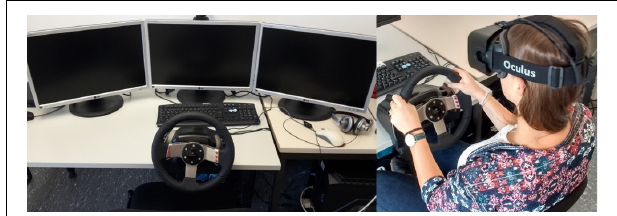
FIGURE 1 | Simulator set-up in the triple-monitor condition and participant in the HMD